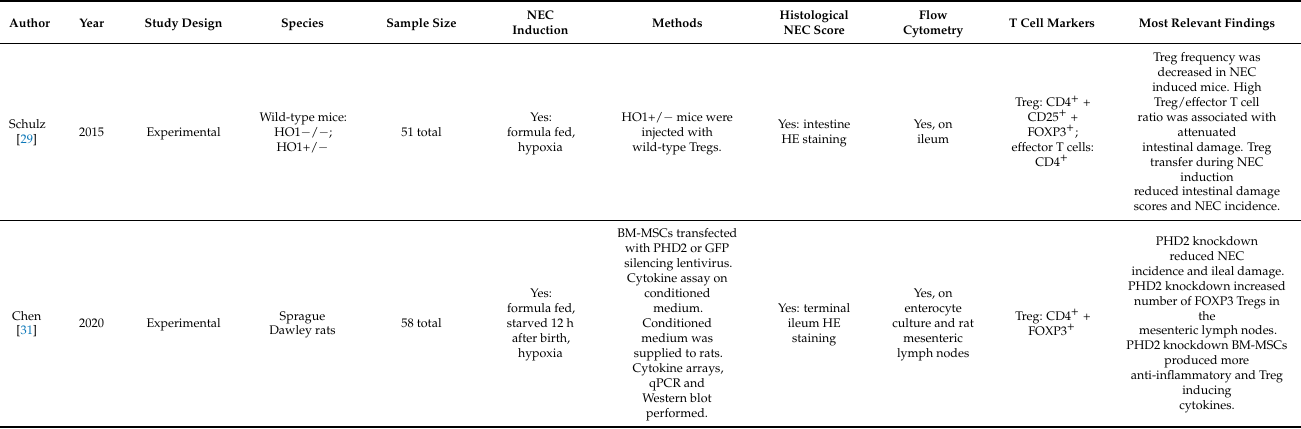
Table 2. Characteristics and main findings of included inflammation related studies.